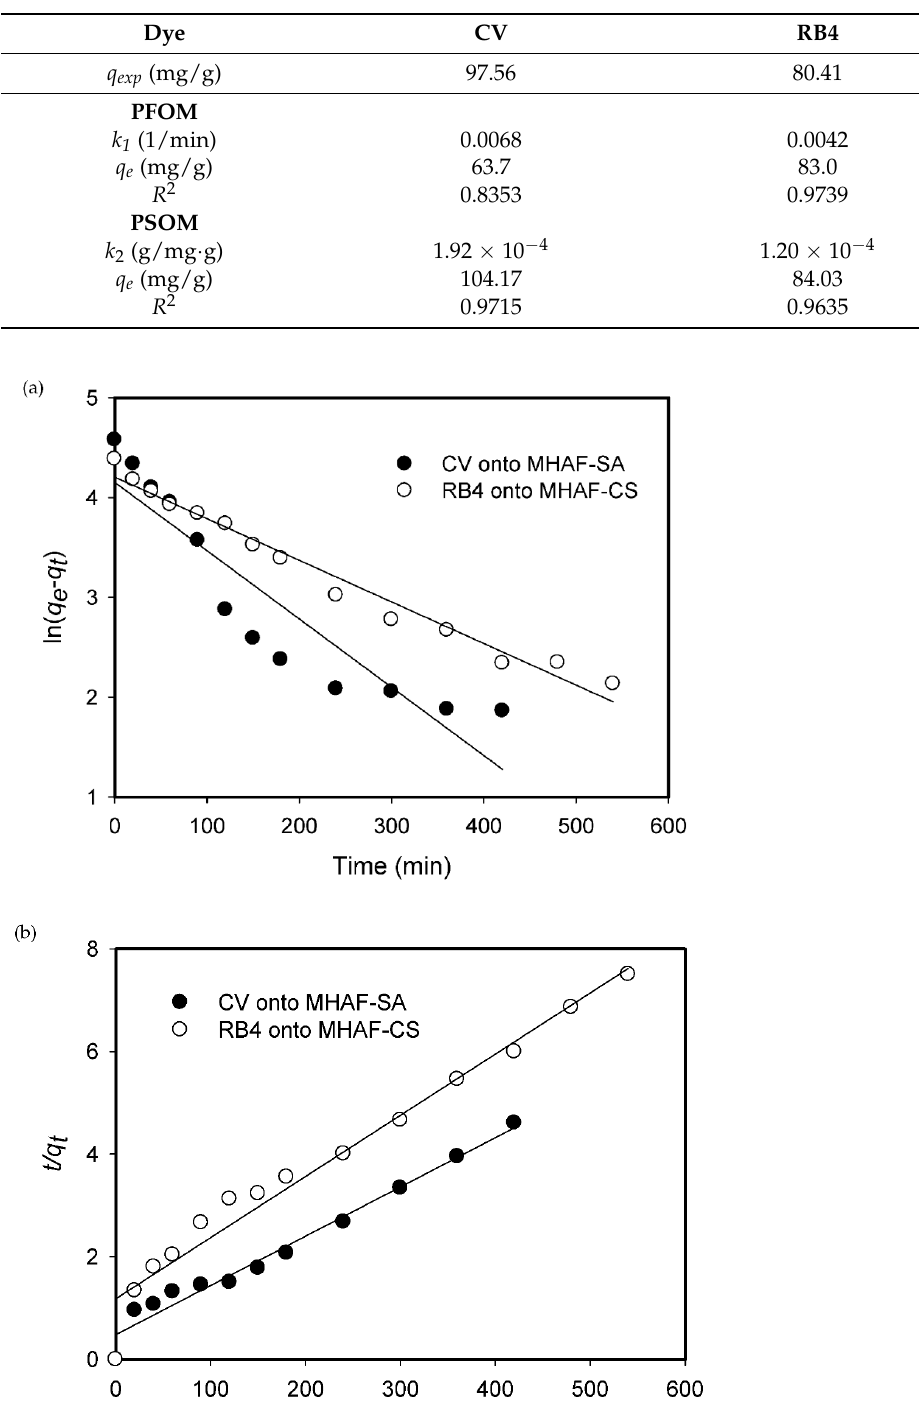
Table 1. Kinetic parameters for the adsorption of dyes onto hydrogel beads at 40 ◦ C.